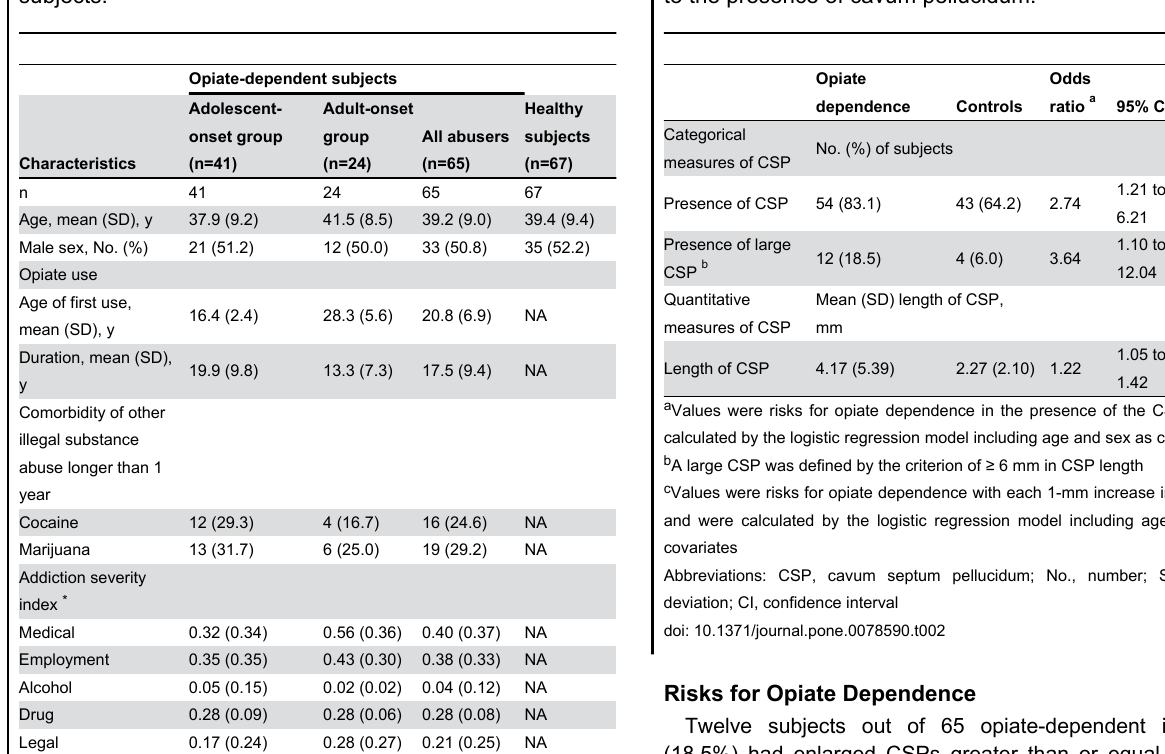
Table 1. Demographic and clinical characteristics of study subjects.